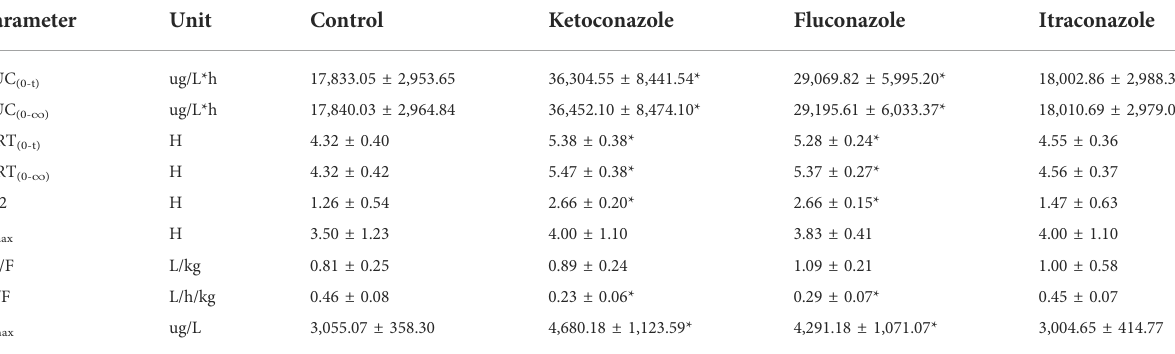
TABLE 4 Main pharmacokinetic parameters of pyrotinib in the control group, ketoconazole group, fl uconazole group and itraconazole group ( n = 6, mean ± SD). Parameter